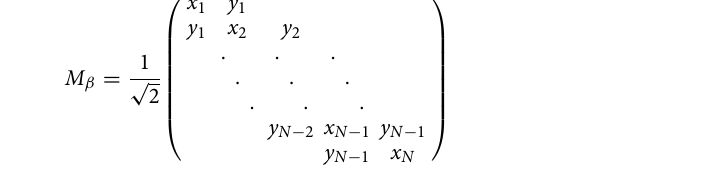
Figure 6. Scree plots of Gaussian β ensemble with β ( 0.01, 1 whole range β . The Poissonian behavior (cid:31) k ∈ ] eigenvalues are practically uncorrelated with finite matrix dimension and numerical accuracy. In none case does the super-Poissonian behavior appear, suggesting no NEE regime